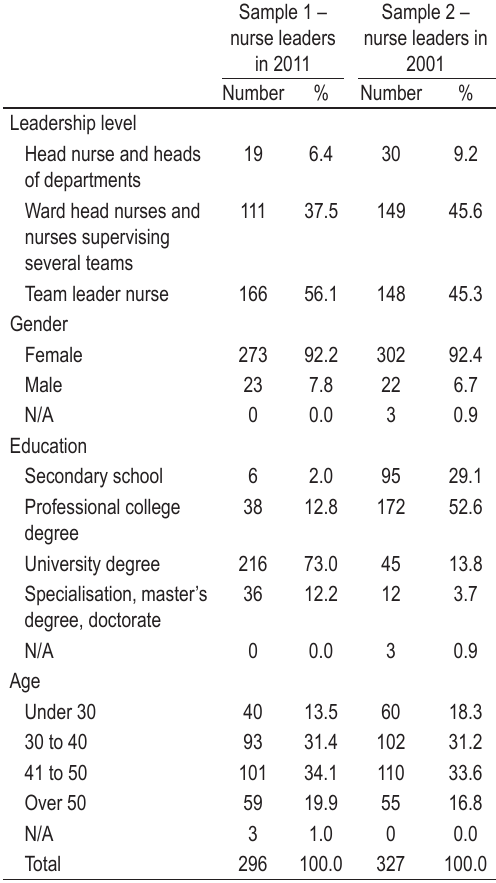
Table 1. Demographic data on the sample of nurse